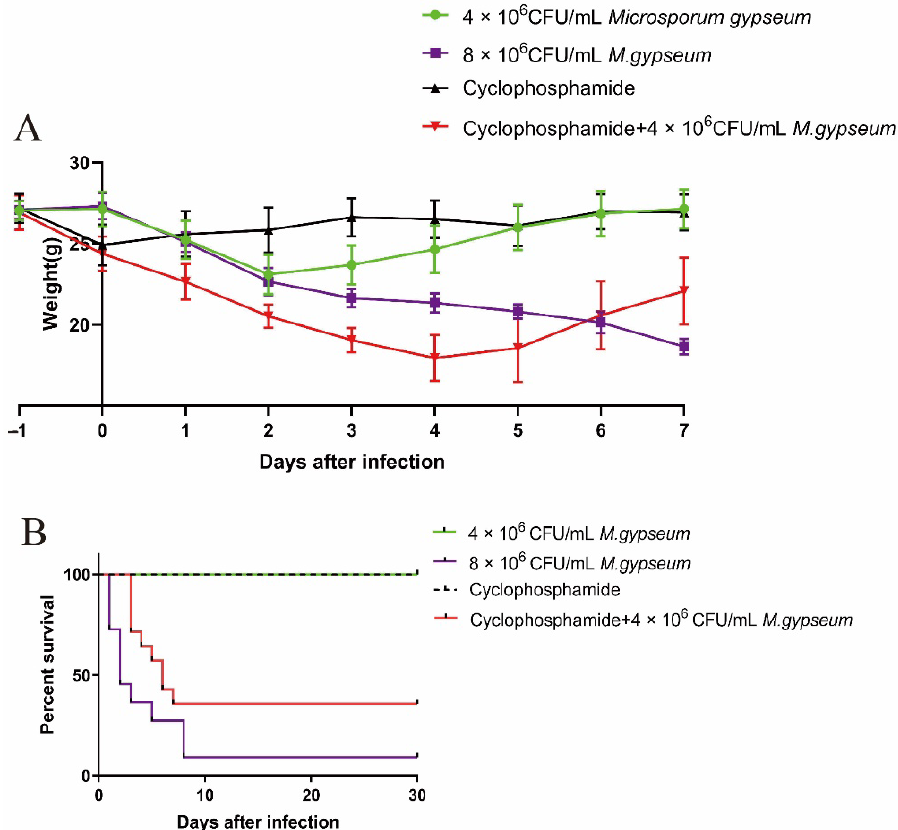
Figure 1. Weight and mortality of mice: ( A ) Weight change of mice after i.v. infection with Microsporum gypseum , cyclophosphamide was injected i.p. into two groups of mice on the day before infection with M. gypseum (15 mice per group); ( B ) Survival curves of mice after i.v. infection with M. gypseum , cyclophosphamide was injected i.p. into two groups of mice in the day before infection with M. gypseum (15 mice per group). The results are presented as mean ± SD and represent three individual experiments.